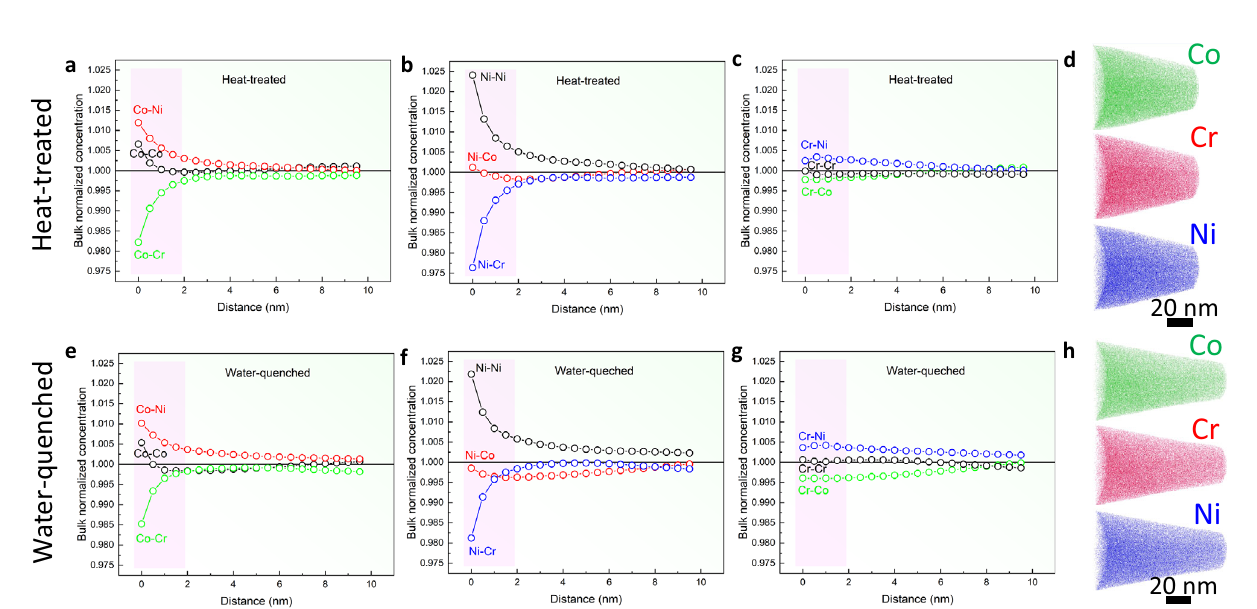
Fig. 6 | APTpartialradialdistributionfunctions(RDFs)oftheheat-treatedand water-quenchedCoCrNisamples.a , b , c and e , f , g arethecalculatedpartialRDFs from the APT data with Co, Ni, and Cr as the center atom, respectively, for heat- treated and water-quenched CoCrNi samples. Note that the partial RDFs were